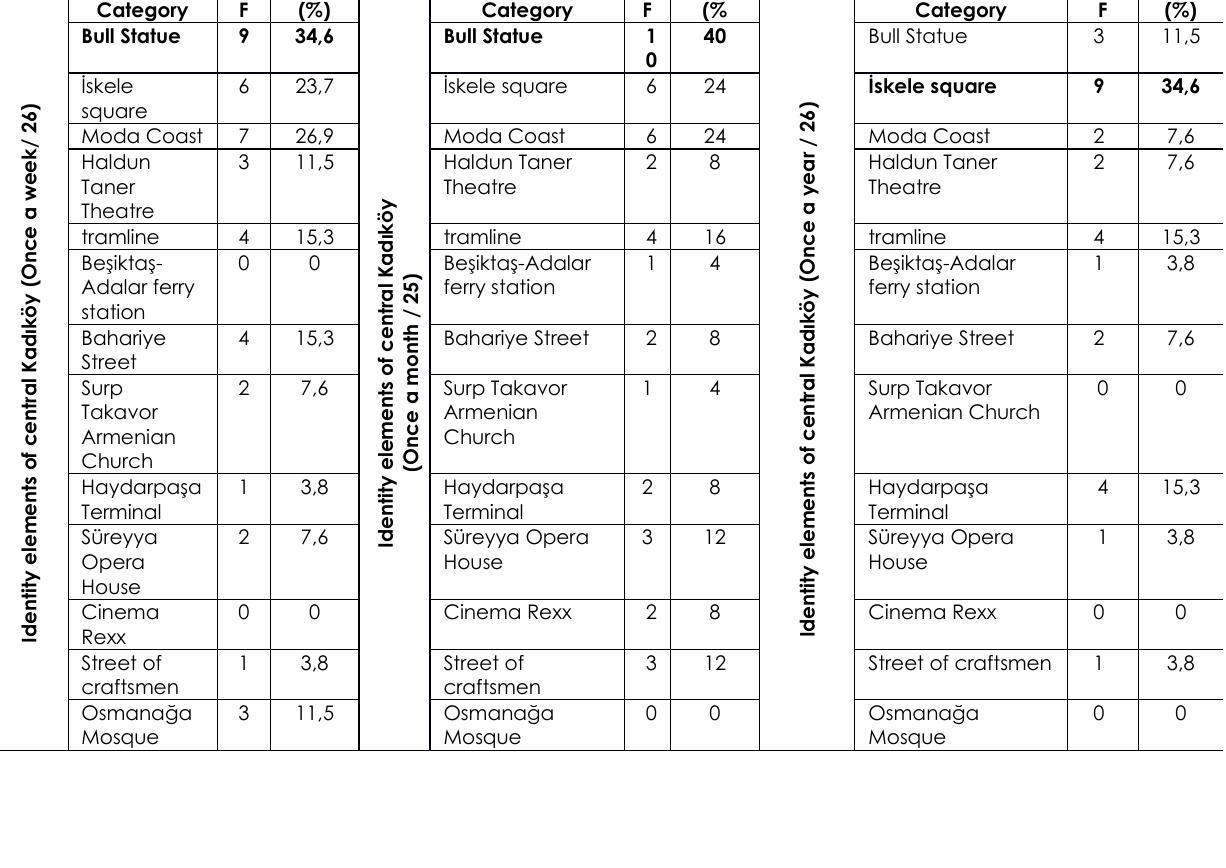
Table 6. The Analysis of Identity Elements via Variable of Usage